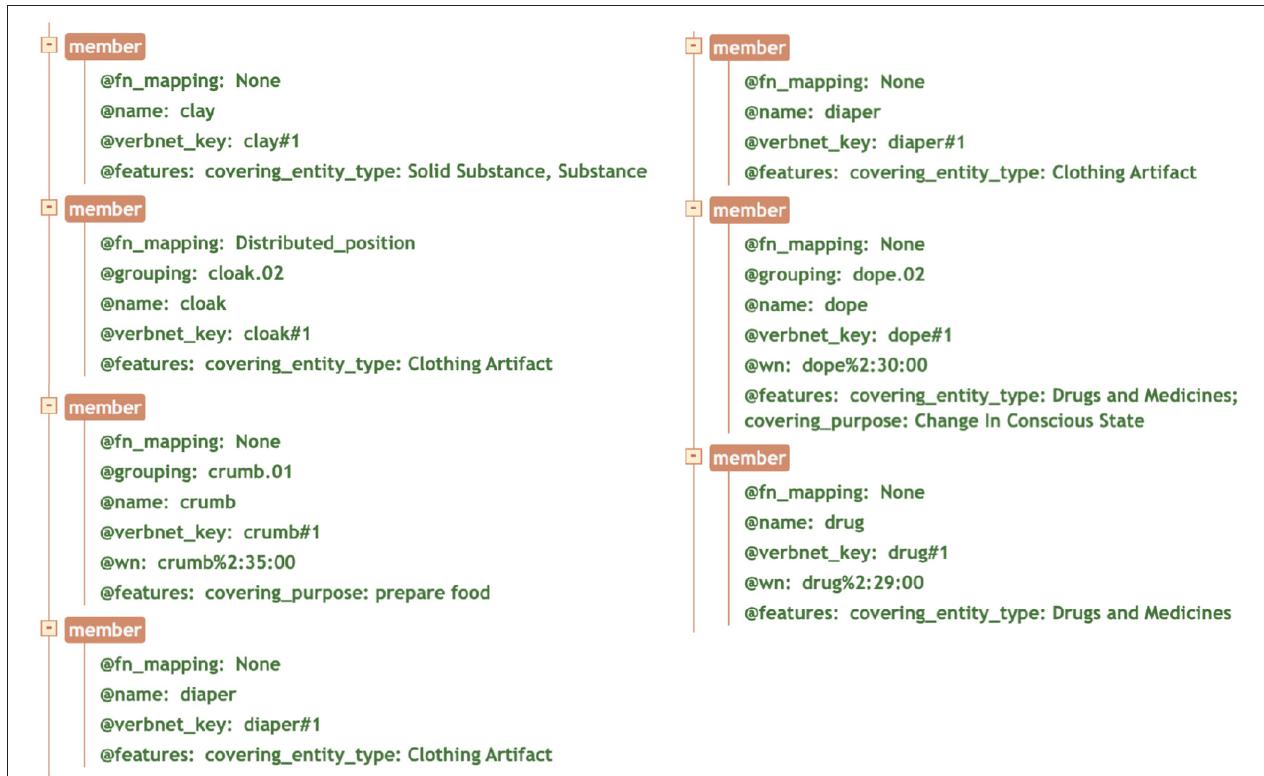
FIGURE 10 | A snapshot of the tree view of the XML file for the Butter-9.9 class, selected verbs that contain verb-specific features. @fn_mapping = FrameNet mapping; @grouping = OntoNotes grouping; @name = verb lemma; @verbnet_key = sense disambiguation of the verb in verbnet; @wn = WordNet mapping; @features = verb-specific features, as a list of key-value pairs (feature type: feature